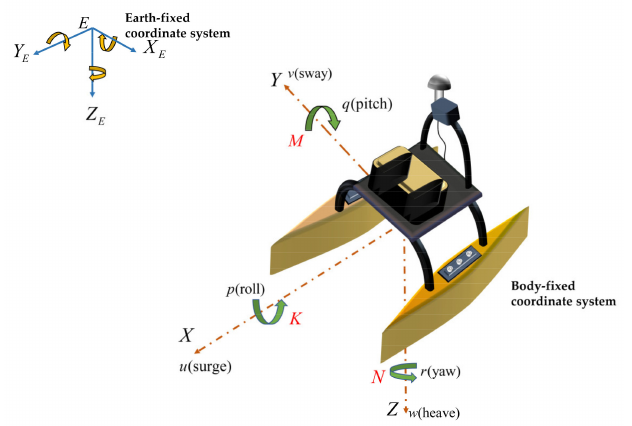
Figure 1. Motion variables for USV.